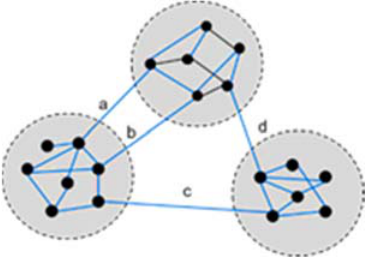
Figure 3. Illustration of edge-betweenness